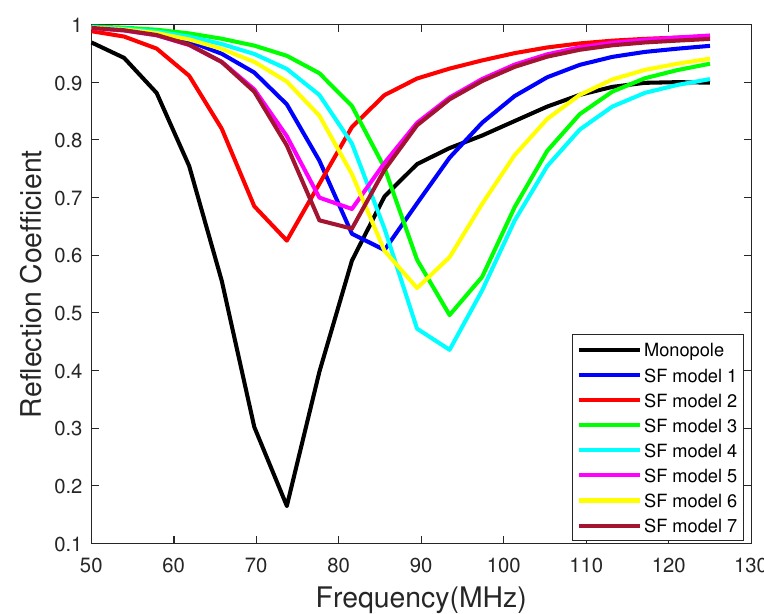
Figure 6. Reflection coefficient vs. the frequency of operation. Single-fold model 4 (SF model 4) shows the highest far-field radiated power of all single-fold antenna models. According to the cyan curve in Figure 5, SF model 4 radiates 0.8 W at 95 MHz. The only difference between this model and SF model 1 is that the return wire length ( l 2 ) is shorter by 10 cm. According to the results, reducing l 2 or increasing the separation between the ground-to-wire separation ( w ) increases the power radiated in the far field. Here, again, the resonance length of the antenna is around 79 cm, which is higher than the physical height of the antenna. SF model 5, shown in magenta, was created by increasing the return wire length ( l 2 ) by 5 cm or by decreasing the ground-to-wire separation ( w ) by 5 cm. According to the simulation results, this model shows the lowest far-field radiated power compared to all models. In conclusion, increasing w or decreasing l 2 increases the far-field radiated power. The last two models, SF models 6 and 7, show the far-field radiated power obtained by changing the feed wire radius ( ρ 1 ) while keeping the return wire radius ( ρ 2 ) fixed at 1.5 mm. In SF model 6, ρ 1 is twice the ρ 2 value and, in model 7, it is halved compared to the other. From the obtained results, increasing the feed wire radius compared to the return wire radius increases the far-field radiated power (in yellow) compared to the case where the two radii are the same, and decreasing it shows the opposite results (in brown). It is worth noting the shift in resonance frequency in the two cases, although there is no change to the total wire length. Figure 7 shows the directivity of each model in 2D spherical coordinates. The coarse- ness of the plots is due to the high increments in phi and θ directions to save computational time. All plots were created at the resonance frequency (frequency with the highest radiated power) of each model and at phi = 0. All models have the same beam width. Single-fold model 4 (shown in cyan) and model 6 (in yellow) have zenith angles θ of 60 ◦ , whereas the other models and the monopole have zenith angles around 50 ◦ . SF models 2 and 4 show the highest directivities at the respective resonance frequencies. The gain of SF model 1 is sig- nificantly lower than the gains of other models and the standard quarter-wave